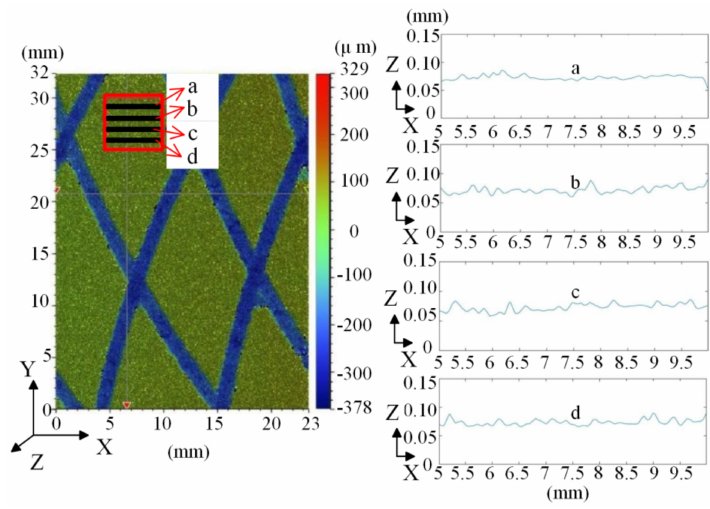
Figure 1. Surface topography and surface topographic